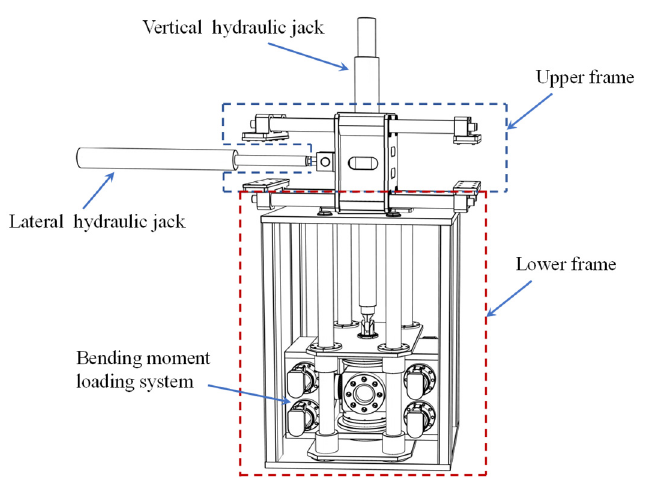
Figure 6. Schematic of the cross-sliding frame.